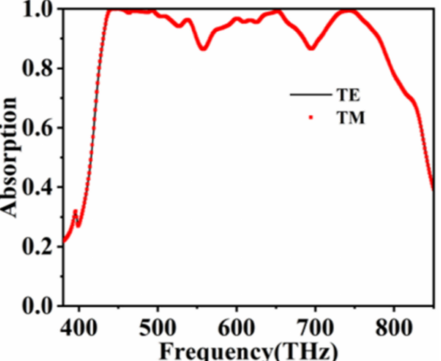
Figure 3. The absorption curves under different polarization